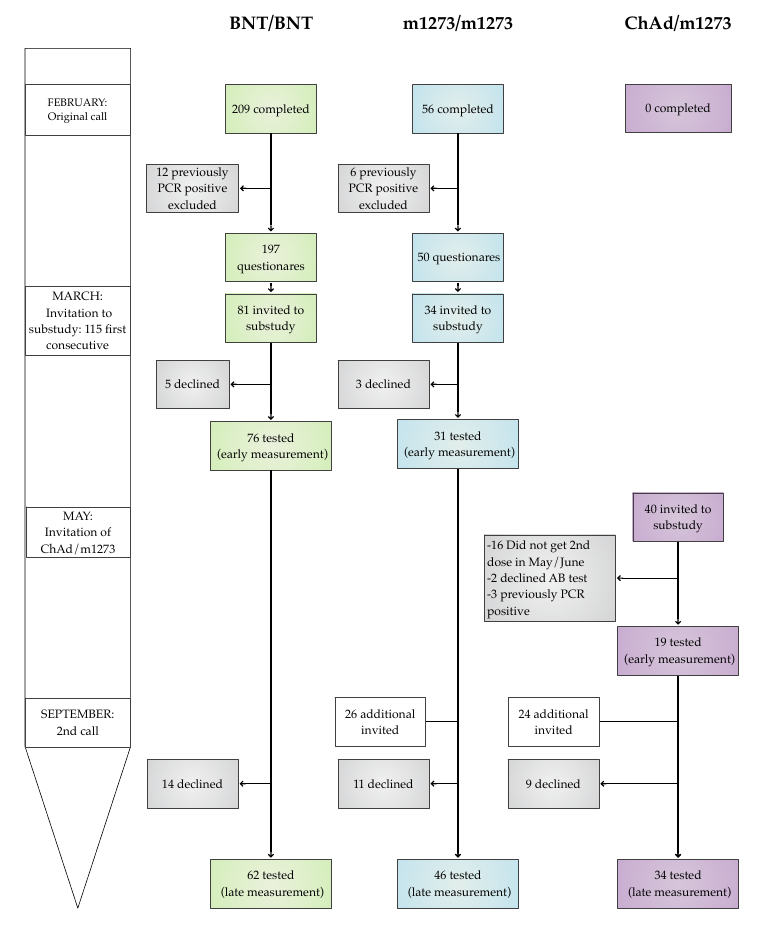
Figure 1. Outline of the study flow illustrating the timeline for recruiting participants accord- ing to vaccine regimens. Green: BNT/BNT, the BNT162b2 mRNA vaccine from Pfizer/BioNTech. Blue: m1273/m1273, the mRNA-1273 vaccine from Moderna. Purple: ChAd/m1273, the heterolo- gous vaccine regimen combining ChAdOx1 vaccine from AstraZeneca with m1273 from Moderna. Early and late measurement refers to antibody level on average one and six months after completion of a vaccine regimen with a second vaccine dose,